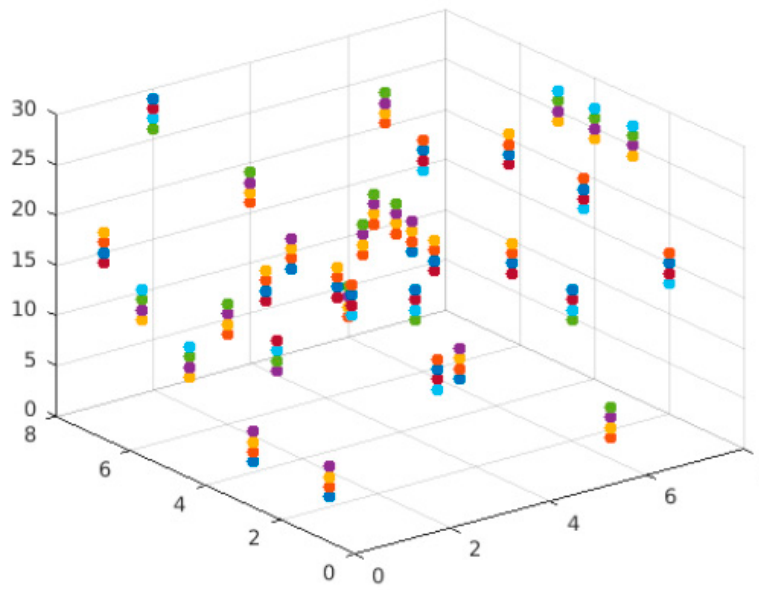
Figure 2. Example of part of sensing data cube S . Colored dots denote non-zero entries (activated pixels) whereas white part of the cube is all zero (dormant pixels). Both coded aperture and coded exposure are present in this example.